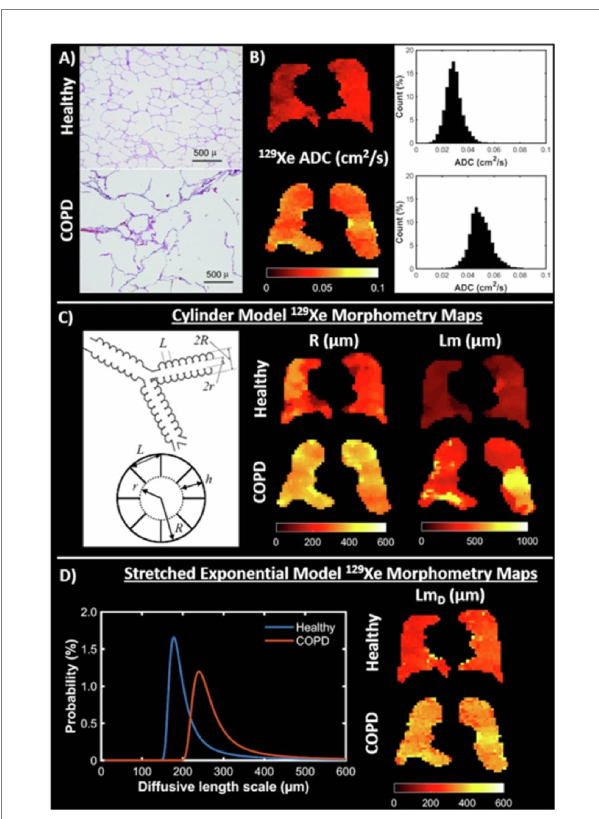
FIGURE 2 Diffusion imaging. (A) Examples of histological slides from a healthy lung (top) and lung with emphysema (bottom) that are used to calculate mean linear intercept (Lm) measurements. (B) 129 Xe ADC maps and whole lung ADC histograms for a healthy volunteer (23-year-old female, top) and chronic obstructive pulmonary disease (COPD) patient (68-year-old male, bottom). (C) (Left) Schematic drawing of the cylindrical model of acinar airway geometry based upon the Haefeli-Bleuer and Weibel acinar geometry (73). (C) (Right) Cylinder model 129 Xe lung morphometry maps of acinar airway radius (R) and mean linear intercept (Lm) in the same healthy volunteer and COPD patient as in (B) . (D) (Left) Probability distributions of diffusive length scale derived from the stretched exponential model for the same healthy volunteer and COPD patient. (D) (Right) Stretched exponential model 129 Xe lung morphometry maps of mean diffusive length scale (Lm D ) for the same healthy volunteer and COPD patient. Adapted with permission from